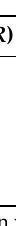
Table 2. Ratio of relative expression of sox genes in B. diazoefficiens wild type and soxR mutant 6806 grown under mixotrophic and heterotrophic conditions a .